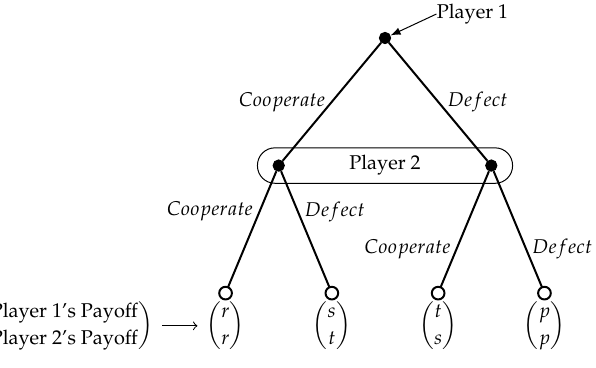
Figure 1. An extensive form of the classical prisoner’s dilemma game. Two stages of the game are shown, but one can easily see how it